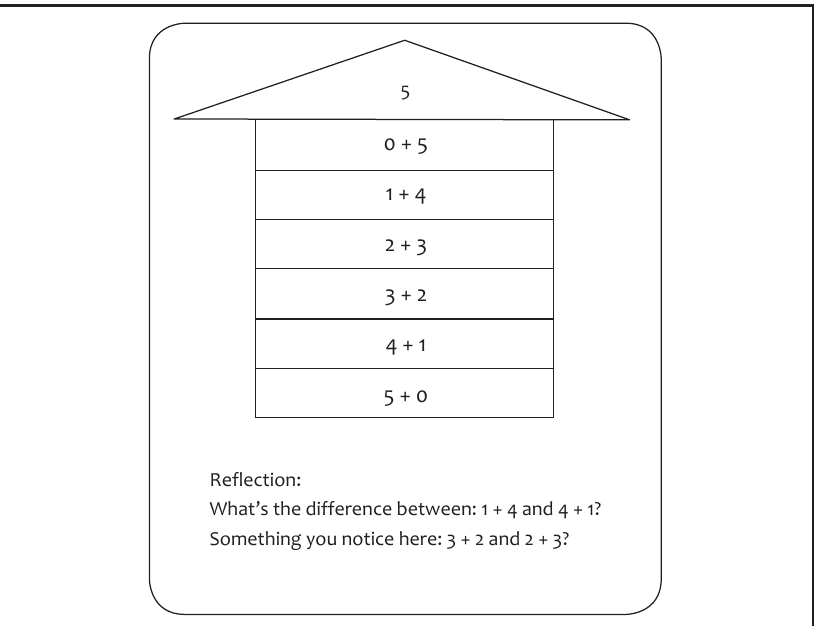
Figure 9: Introduction of the addition